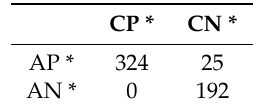
Table 3. Detection rate of concave